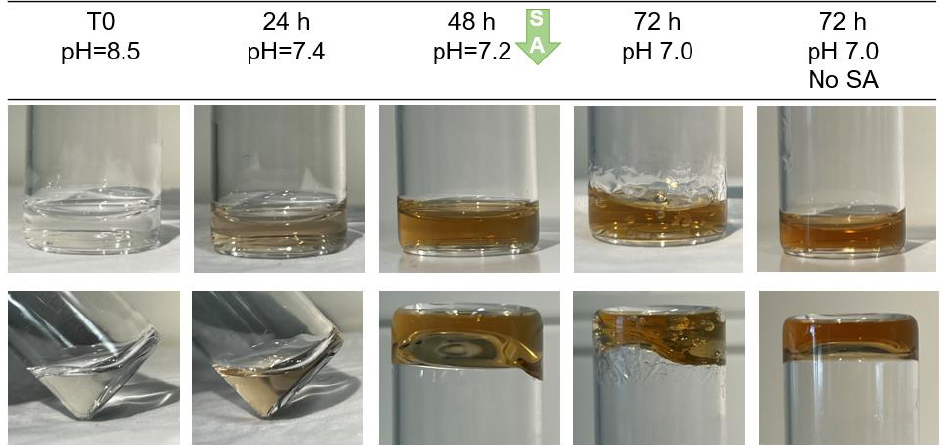
Figure 3. Macroscopic images showing the progressive change of color of HA-Dop (DS 5%) after basification with NaOH. At 48 h, the crosslinking was quenched by the addition of SA, and 24 h later, the gel color remained unchanged. The gel without addition of SA slightly intensified and reddened, suggesting that SA was effective to quench the crosslinking reaction.